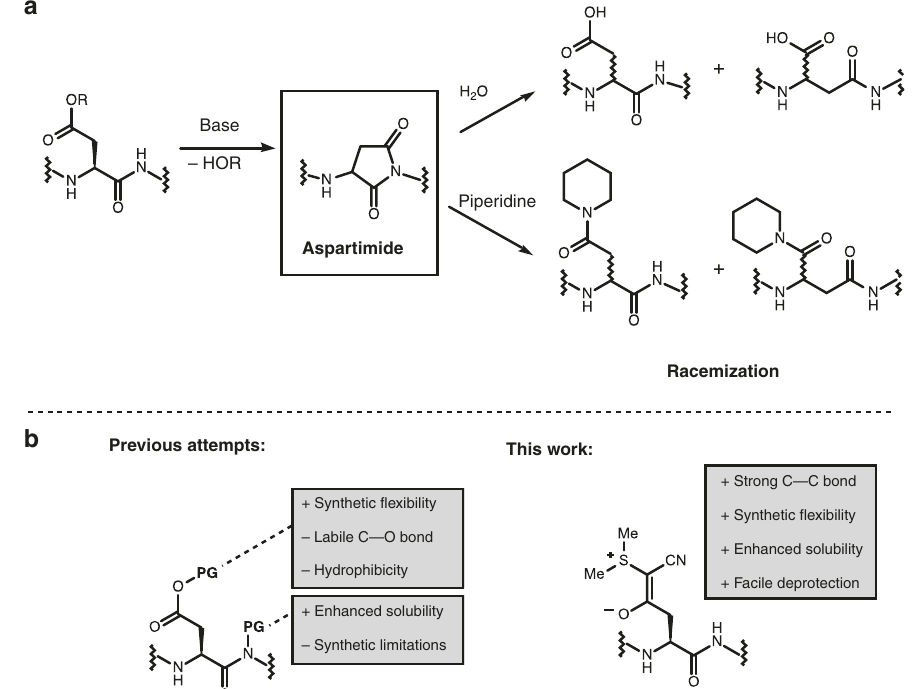
Fig. 1 Aspartimide formation during SPPS. a Base-promoted aspartimide formation during SPPS results in racemization and formation of α - and β - peptides. b Previous attempts of minimizing aspartimide formation included the usage of bulky esters on aspartic acid side chain and protection of amide backbone. In contrast, this work utilizes a stable C – C bond that masks the side-chain carboxylic acid of aspartic